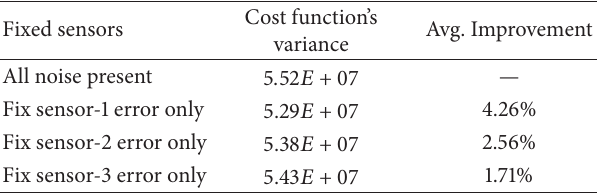
Table 4: Error elimination of sensors with the approximation methodology